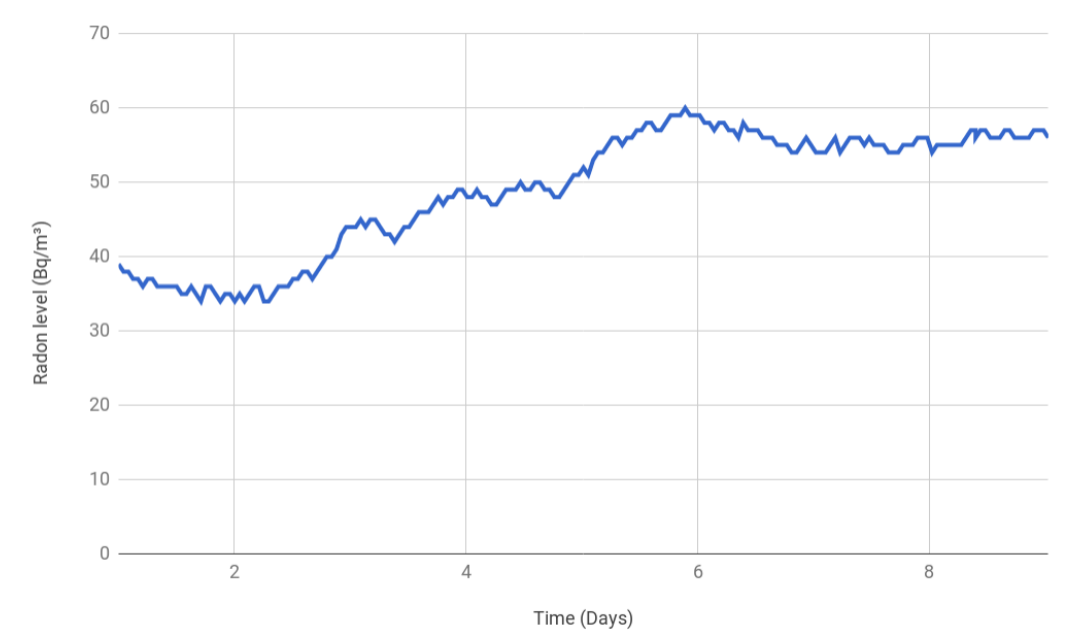
Figure 11. Radon gas concentration in an urban